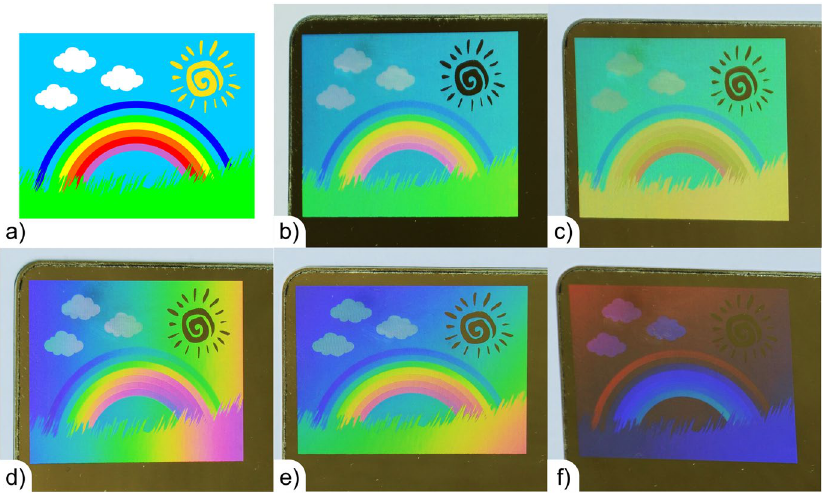
Figure 8. ( a ) Target “Rainbow” picture and observed structural colours under different viewing angles of ( b ) 22° (target angle) and ( c ) 25°; ( d ) at a viewing angle of 22°, but with the sample rotated by 180°, ( d ) 90° and ( e )